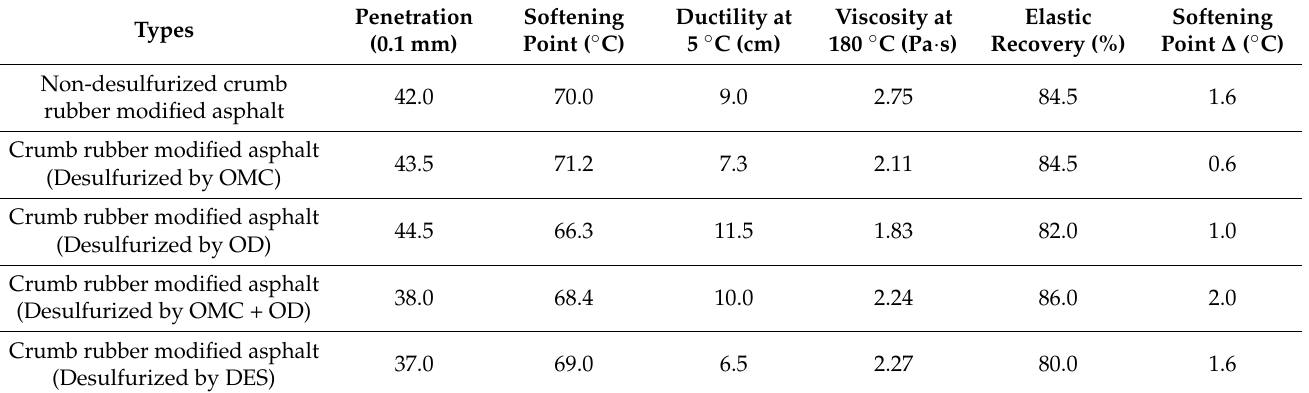
Table 1. The physical properties of asphalt modified by crumb rubber treated with different desulfur- izer